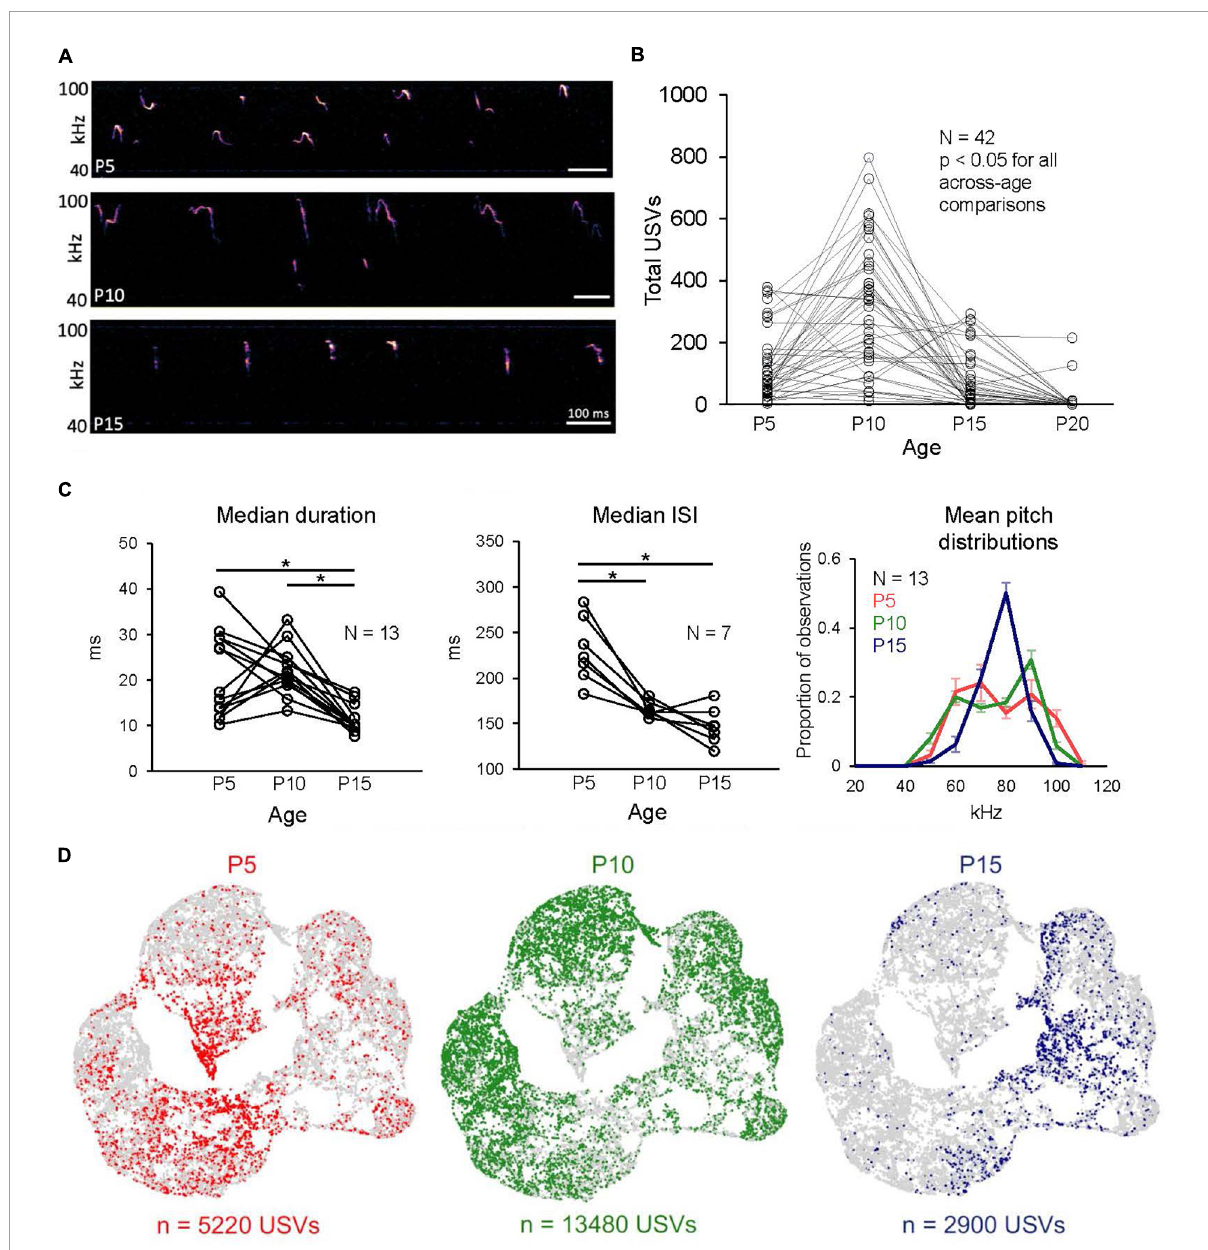
FIGURE1 Rates and acoustic features of isolation USVs change over early postnatal development. (A) Spectrograms of representative isolation USVs produced by P5, P10, and P15 mice. (B) The number of isolation USVs is shown for N = 42 pups recorded at P5, P10, P15, and P20. (C) (Left) Median values of USV duration vs. age are plotted for N = 13 mice that produced > 50 USVs at P5, P10, and P15 ( p < 0.01 for P5 vs. P15 and P10 vs. P15, Friedman test followed by post-hoc tests). (Middle) Same, for median ISIs ( p < 0.01 for P5 vs. P10, p = 0.02 for P5 vs. P15, Friedman test followed by post-hoc tests). Note that because ISIs > 400 ms are excluded, there are only N = 7 mice with > 50 ISIs at each age. (Right) Distributions of mean pitch are plotted from the same N = 13 pups. Error bars in right panel are S.E.M. (D) UMAP projections of latent syllable representations of USVs produced by P5 (red), P10 (green), and P15 mice (blue). Points represent individual syllables and are closer to each other if acoustically more similar.